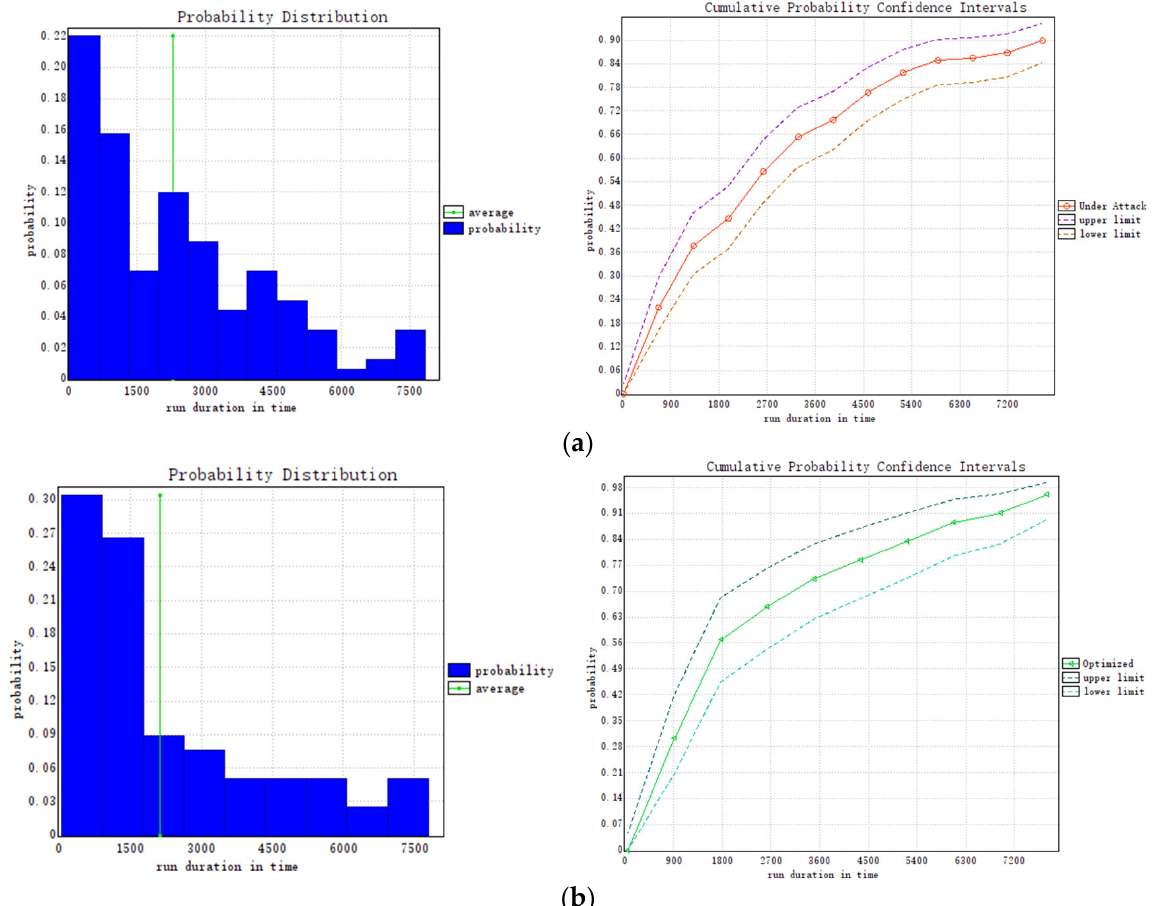
Figure 15. Comparison of results before and after optimization under the FMA ‐ RNN. ( a ) This figure shows the successful response rate under the FMA ‐ RNN without optimization. ( b ) This figure shows the successful response rate under the FMA ‐ RNN after optimization.